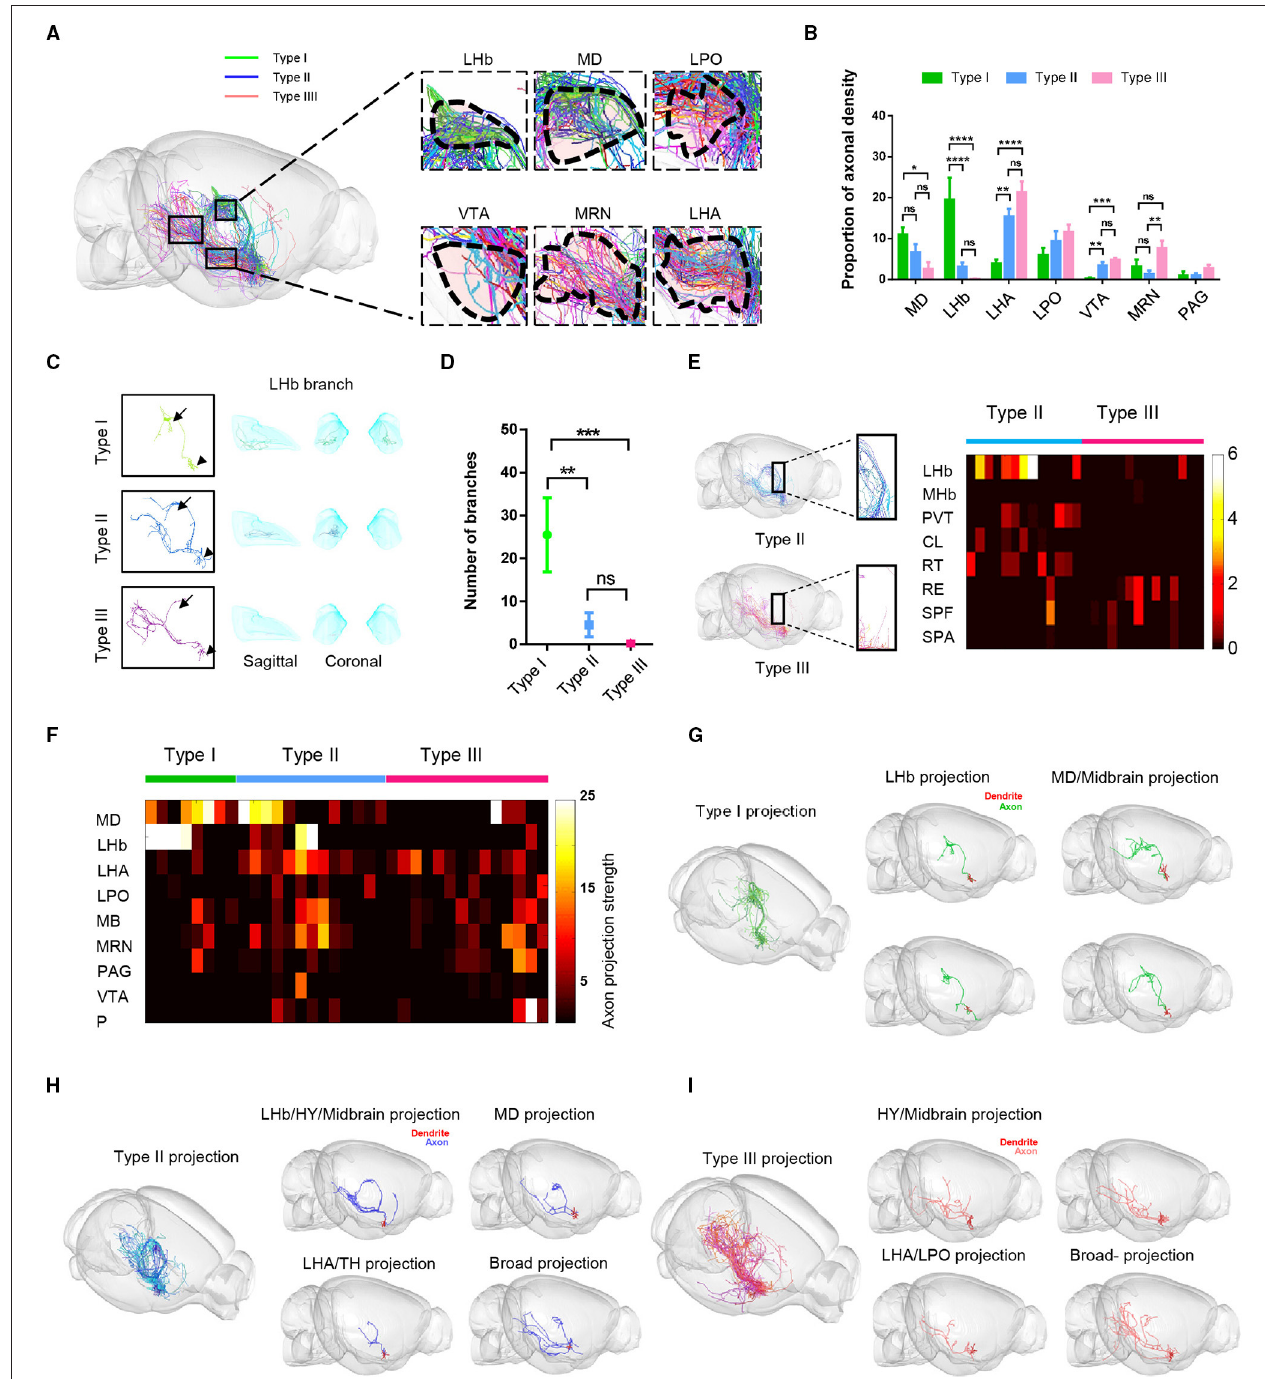
FIGURE 4 | Fiber distribution patterns of the three types of VP neurons. (A) The sagittal view of the color-coded fiber distribution of VP neuron types. (B) Quantification analysis of the percentage of axon density in (A) . The three types show the difference in MD, LHb, LHA, VTA, and MRN; ** P < 0.0067, *** P = 0.0001, **** P < 0.0001, one-way ANOVA with Turkey’s multiple comparisons test. (C) Morphology of a representative type I, type II, and type III neuron. Arrowheads point to the somata and the arrows to the LHb. (D) The number of bifurcation points for the three types of VP neurons in the LHb. ** P = 0.0026, *** P = 0.0002; t -tests; error bar indicates SEM. (E) Axonal fiber distribution of type II and type III neurons in the thalamus. The boxed areas in the left show zoom-in views of axonal segments in the PVT and RT. The heatmap on the right shows axonal labeling intensity. (F) The heatmap shows the number of end-terminal points in various brain regions. Rows: brain regions, columns: individual neurons. (G–I) Representative structural images show morphological heterogeneity within type I (G) , type II (H) , and type III neurons (I) . CL, central lateral nucleus of the thalamus; SPA, subparafascicular area.